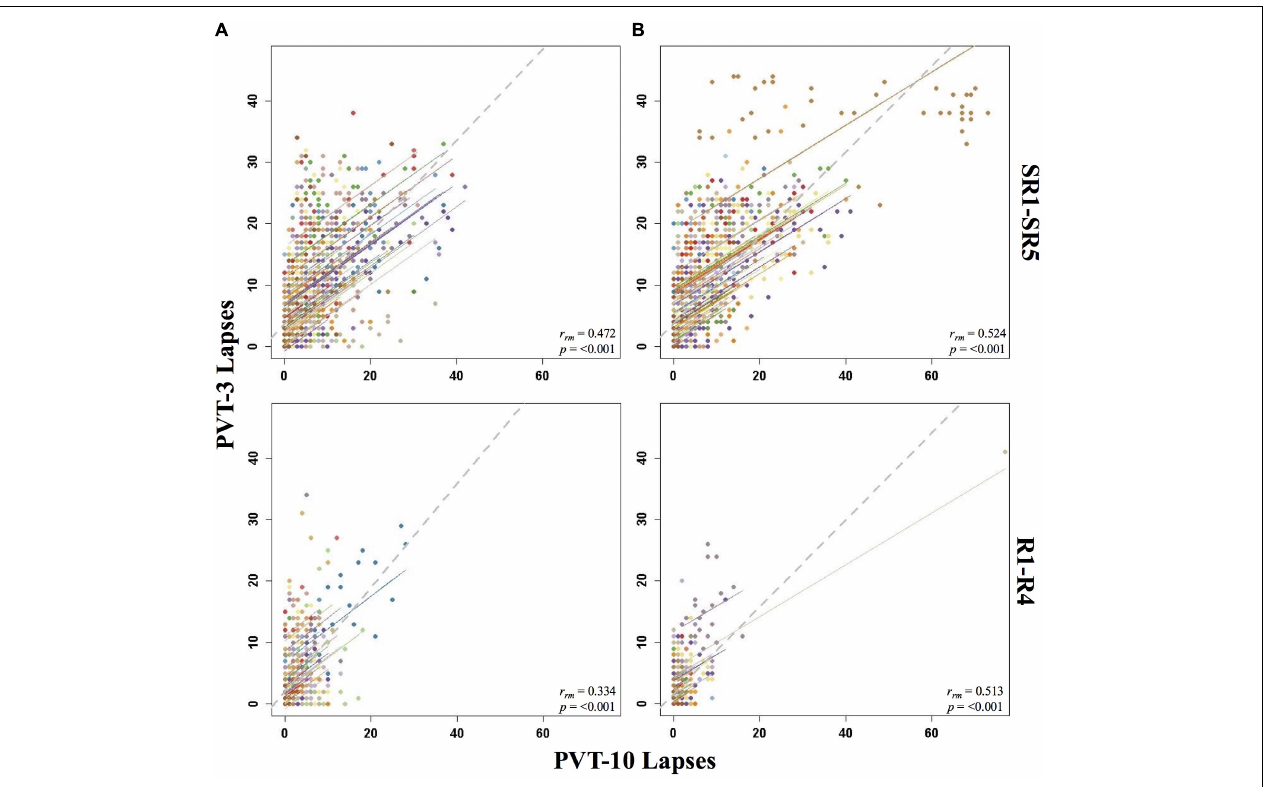
FIGURE 1 | Rmcorr plots of repeated-measures correlations between 10-min Psychomotor Vigilance Test (PVT-10) and 3-min Psychomotor Vigilance Test (PVT-3) lapses by study phase for Condition A (A) and Condition B (B) . Each color represents a distinct participant with each point showing performance on both measures at one time point while the corresponding line shows the rmcorr fit for that participant (Bakdash and Marusich, 2020; R Core Team, 2020). The gray dashed line represents the regression line obtained by ignoring repeated measurements and treating the data as independent observations; r rm represents the common within-individual association (rmcorr). Rmcorr effect sizes were interpreted as follows: 0.00–0.29, negligible; 0.30–0.49, weak; 0.50–0.69, moderate; 0.70–0.89, strong; and 0.90–1.00, very strong. Included time points for study phases were as follows: sleep restriction day one from 0800 h through sleep restriction day five at 2000 h (SR1-SR5) and recovery day one from 1000 h through recovery day four at 2000 h